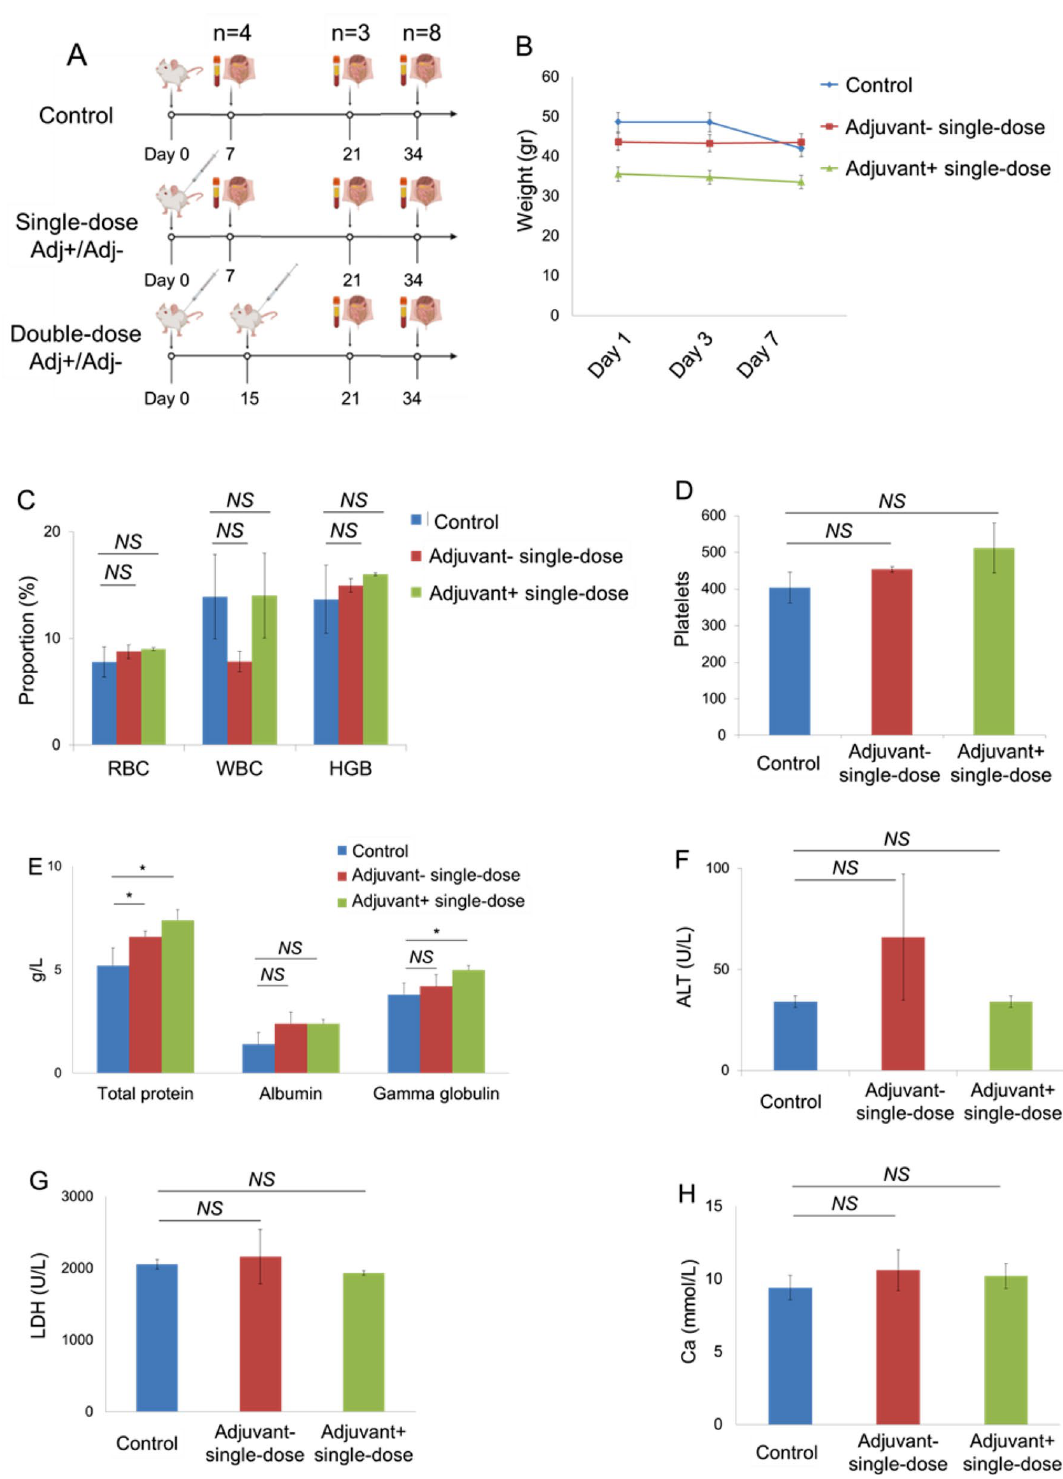
Figure 5. Day-7 Safety analysis of the vaccine candidates, SK-01 V1, and OZG-3861 V1. ( A ) In vivo inactivated vaccine candidate treatments and euthanizations. Experimental plan of in vivo SK-01 V1 and OZG-3861 V1 intradermal treatment as single or double dose. ( B ) Graph showing weight change during one week in groups; control, blue; adjuvant negative single-dose (OZG-3861 V1), red; adjuvant positive single-dose (SK-01 V1), green. ( C ) Bar graph showing hemogram analysis including RBC, WBC, and HGB levels in the groups. ( D ) Bar graph showing the change in platelet proportions between groups in one week. ( E ) Bar graph showing levels of total blood protein, albumin, and gamma-globulin (g/L) in the groups. Bar graphs showing levels of ( F ) ALT (U/L), ( G ) LDH (U/L) and ( H ) Ca (mmol/L) in the blood of mice groups. ( I ) Histopathologic analysis on day 7 of the lung, jejunum of intestine, liver, spleen, cerebellum, hippocampus, kidney, and skin. Purkinje neurons (arrow). The thin double-headed arrow is space, the thick arrow is a picnotic